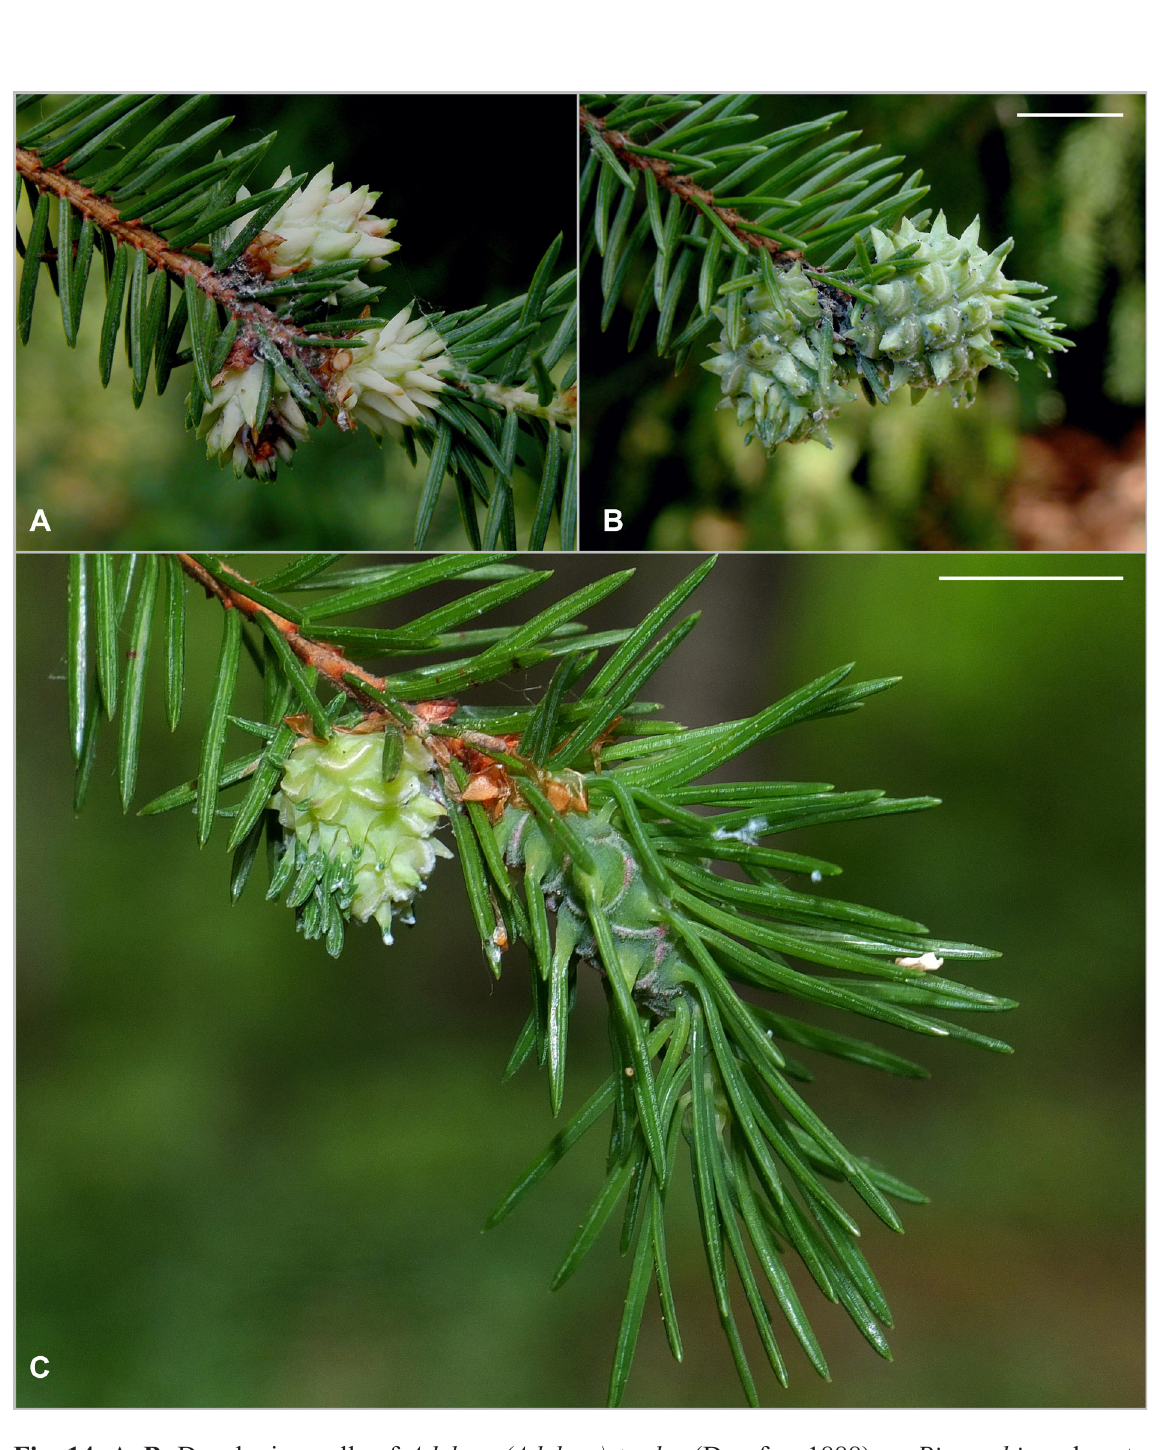
Fig. 14. A–B . Developing galls of Adelges (Adelges) tardus (Dreyfus, 1888) on Picea abies , close to galls of A. (Sacciphantes) abietis (Linnaeus, 1758). C . Half-grown galls of A. tardus and A. abietis on the same twig. Note the tufts of protruding needles on the A. tardus galls, apparently due to interference from A. abietis . Scale bars: 10